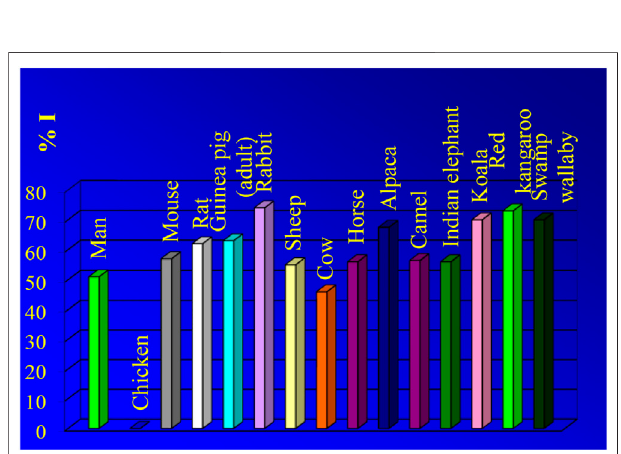
FIGURE4| Values ofthemembranediffusionalpermeability (P d )towaterofRBCs ofman andseveralanimal species. TheSDvaluesare: Man: 25 0 C:0.50;37 0 C: 0.12; Mouse: 25 0 C: 0.30; 37 0 C: 0.81; Rat: 25 0 C: 0.23; 37 0 C: 0.21; Guinea pig (adult).25 0 C: 1.31; 37 0 C: 2.02; Guinea pig (preganant female): 25 0 C: 1.31; 37 0 C: 2.02; Guineapig(fetus):25 0 C:0.66;37 0 C:1.16;Rabbit: 25 0 C:0.68; 37 0 C:1.77;Sheep:25 0 C:0.54;37 0 C:0.86;Australiansheep:25 0 C:0.75;37 0 C:1.06; Domestic chicken: 25 0 C: 0.25; 37 0 C: 0.21; Australian feral chicken: 25 0 C: 0.37; 37 0 C: 0.55; Horse 25 0 C: 0.87; 37 0 C: 0.75; Australian horse: 25 0 C: 1.07; 37 0 C: 1.02; Cow: 25 0 C: 0.54; 37 0 C: 0.86; Dog: 25 0 C: 0.20; 37 0 C: 0.22; Cat 25 0 C: 0.50; 37 0 C:0.72.